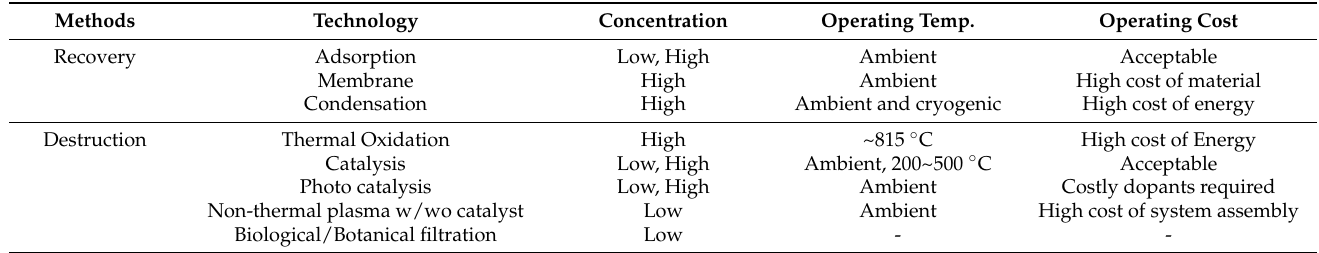
Table 1. Comparison of formaldehyde removal